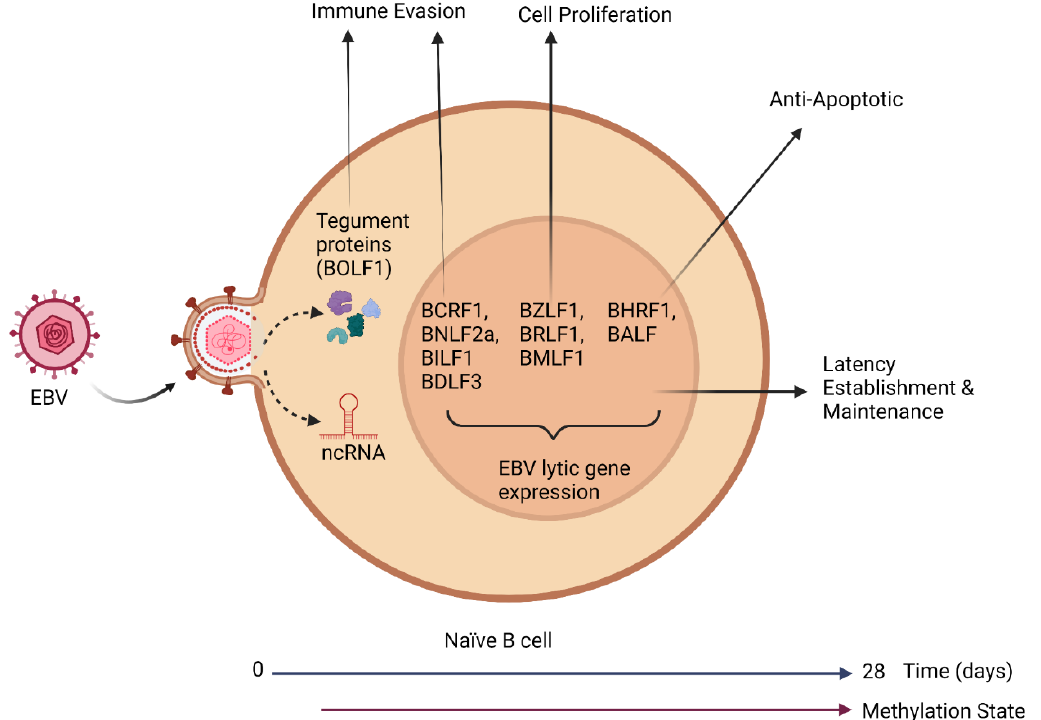
Figure 2. Illustration of a naïve B cell infected by EBV and the role that EBV genes expressed during the pre-latent phase have in modulating cellular functions, such as immune evasion cell proliferation and apoptosis. The pre-latent phase is reported to occur seven to twenty-eight days following infection and continues until the EBV genome is hypermethylated.